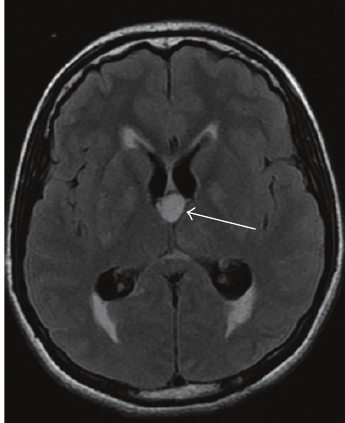
Figure 2:MRIbrainFLAIRimage axial view showinground shaped mass in the third ventricle, with enlarged both lateral ventricles shown by white arrows.